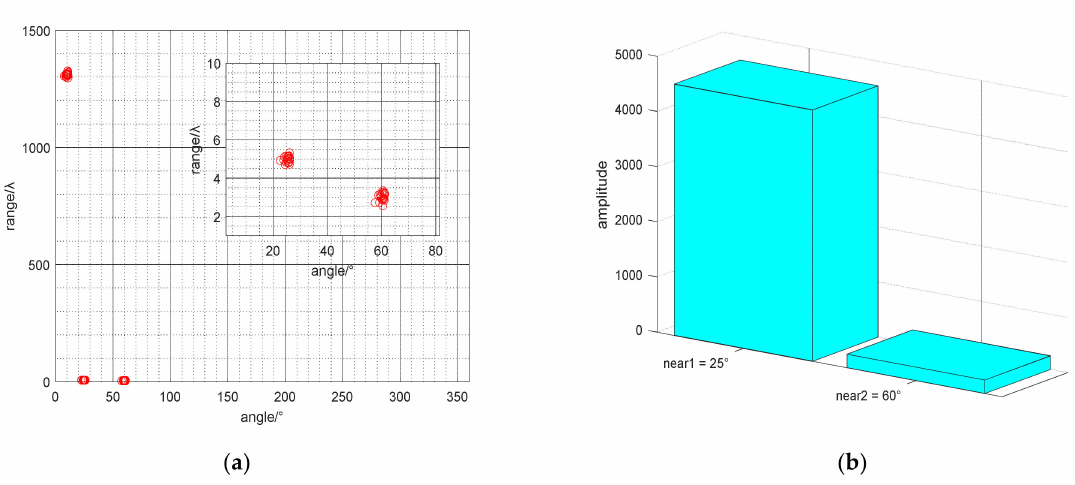
Figure 5. ( a ) The scatter diagram of DOA and range estimation; ( b ) The spectral comparison graph about common DOAs.